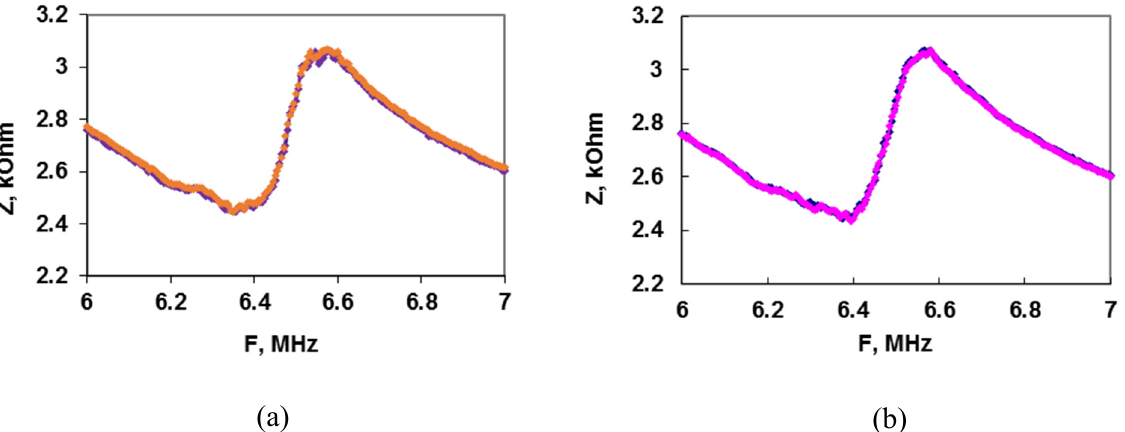
Figure 9. The frequency dependences of the module of the electrical impedance Z for the E. coli pBR-325 cells before (blue curves) and after (orange and pink curves) the CAP treatment with the concentration ( μ g/mL): 2.5 ( a ) and 10 ( b ).